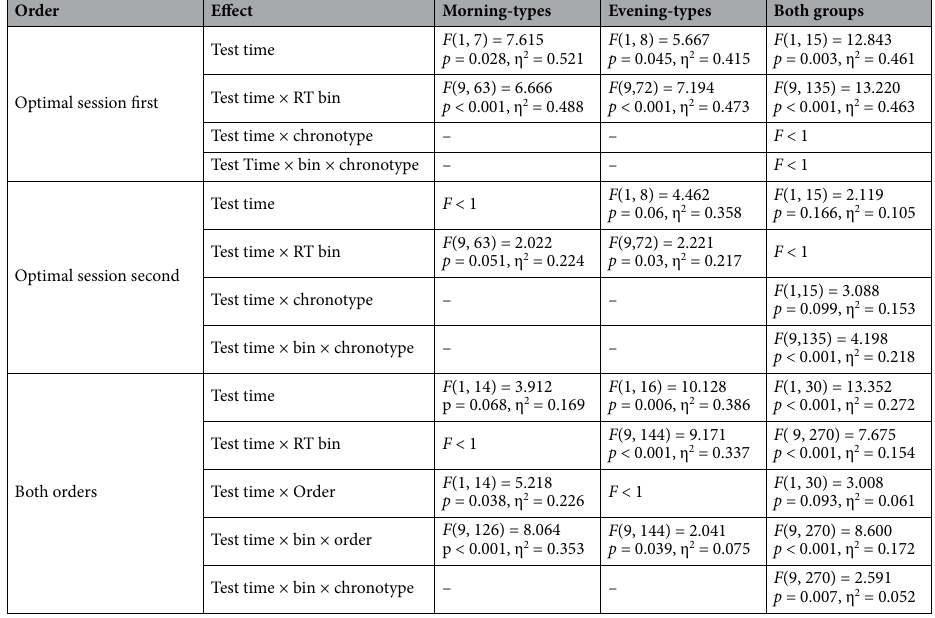
Table 1. Results of ANOVA tests on the mean reaction time (RT) for the psychomotor vigilance task (PVT).